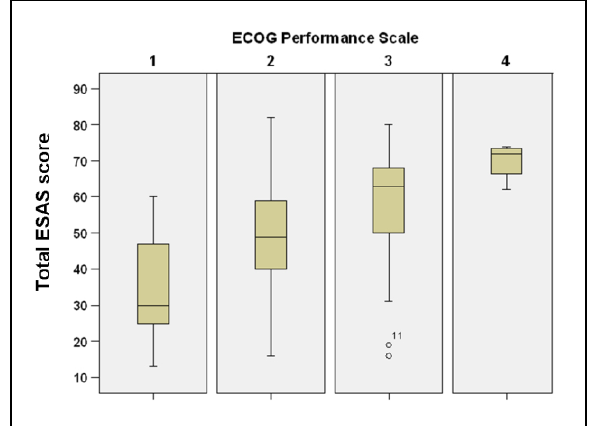
Figure 1. Box plot representation of the relation between ESAS ( Edmonton Symptom Assessment System) and ECOG ( Eastern Cooperative Oncology Group) performance scale